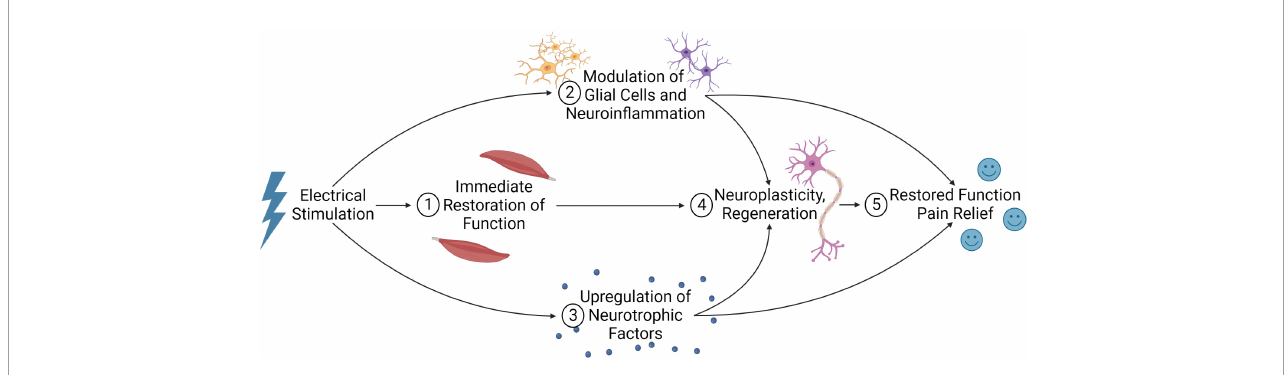
FIGURE7 Summary of the potential mechanisms that electrical stimulation may improve outcomes post-SCI. (1) Electrical stimulation can immediately restore function by activating local neural circuitry and facilitating spared, residual supraspinal inputs to regain functional control below the lesion. (2) Stimulation may also modulate glial cells and neuroinflammation, and (3) upregulate neurotrophic factors. (4) When combined with long-term stimulation and rehabilitation, this may promote neuroplastic remodeling of the spinal cord and possibly axonal regeneration, facilitating supraspinal control below the injury. (5) These mechanisms may account for the restored function and neuropathic pain relief observed in electrical stimulation